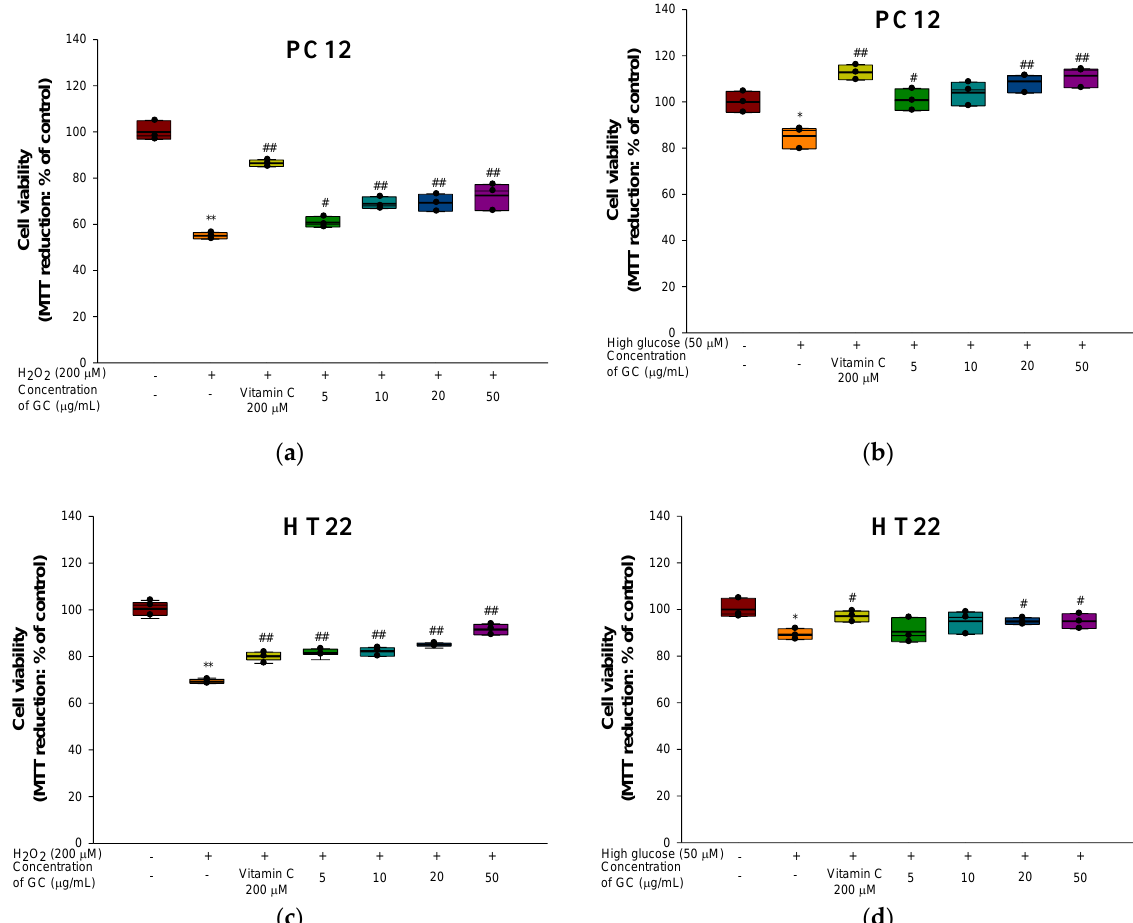
The neuroprotective effects of GC against H 2 O 2 and high glucose in PC12 and HT22 cells are shown in Figures 2 and 3. In the results of cell viability in PC12 cells, the H 2 O 2 - treated group (55.08%) and high glucose-treated group (85.23%) showed cytotoxicity that decreased by 44.92% and 14.77%, respectively, compared to the control group (100%) (Figure 2a,b). On the other hand, treatment of the GC groups with 20 µ g/mL (69.32% and 108.89%) and 50 µ g/mL (72.50% and 111.33%) showed significantly increased cell viability compared to the H 2 O 2 and high glucose-treated groups. In addition, the hippocampal HT22 cells were evaluated (Figure 2c,d). Both the 20 µ g/mL (84.73% and 91.34%) and 50 µ g/mL (94.91% and 94.96%) GC groups showed an increase in cell viability from neurotoxicity caused by H 2 O 2 (69.64%) compared to the high glucose (89.26%)-treated group.